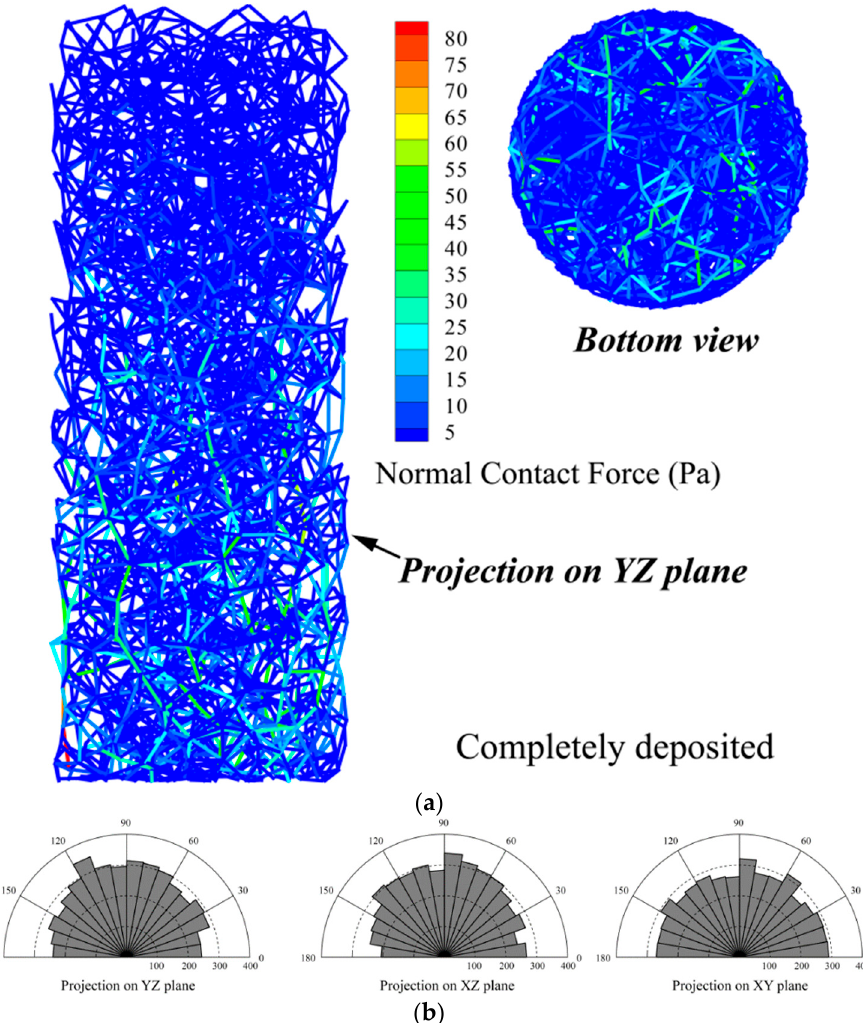
Figure 8. Micro-structure of the cobble sample after deposition: ( a ) distribution of the force-chain; and ( b ) rose plot of the contact direction in particles.